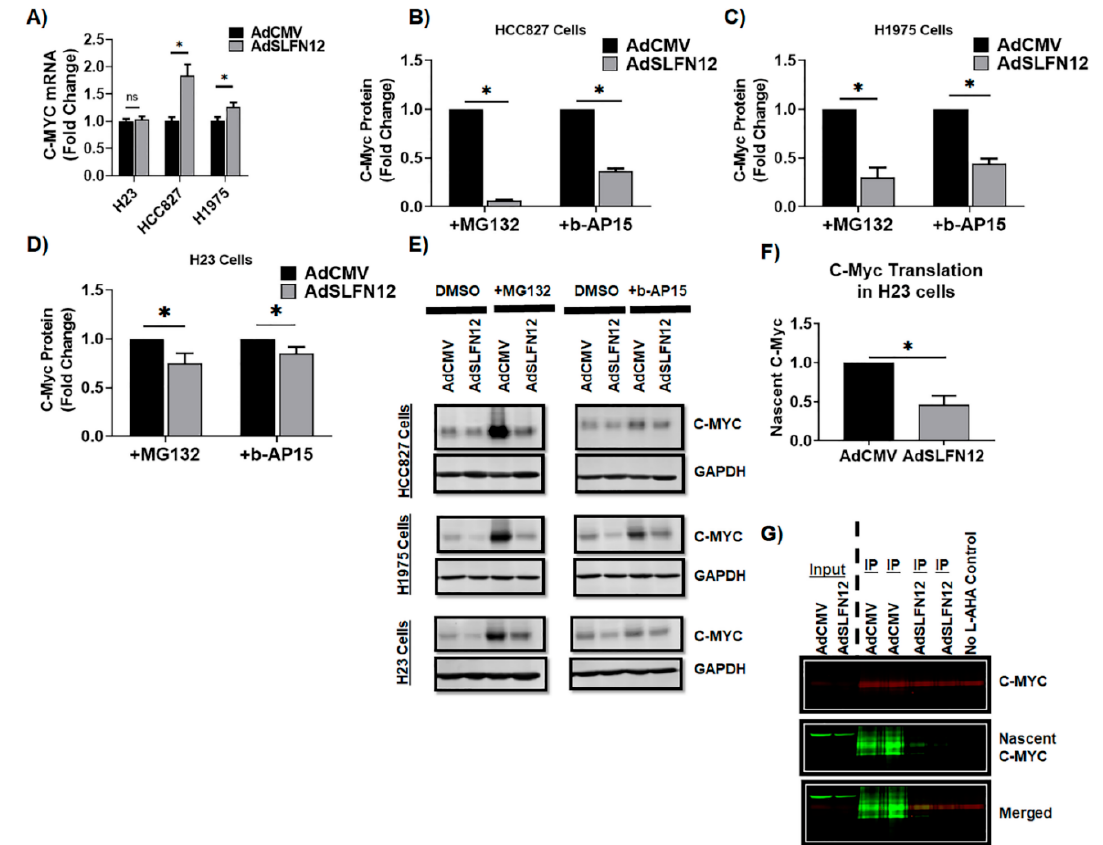
Figure 6. Schlafen 12 reduces c-myc protein translation. ( A ) C-myc mRNA levels analyzed by primer-probe RT-qPCR in HCC827 ( n = 6), H23 ( n = 6), and H-1975 ( n = 6) LUAD cells, 72 hours after AdSLFN12 or AdCMV treatment. HPRT was used as a reference gene and data were normalized to the AdCMV controls (* p < 0.05, ns = non-significant). C-myc protein levels analyzed by Western blot in ( B ) H1975 ( n = 3), ( C ) H23 ( n = 3), and ( D ) HCC827 ( n = 6) cells, with representative Western blot images shown in ( E ), 72 hours after infection with AdSLFN12 or AdCMV control, in the presence of 10 µM of the proteasomal inhibitor MG132 or 1 µM of the deubiquitylase inhibitor b-AP15 (* p < 0.05, GAPDH used as a reference protein). ( F , G ) C-myc protein translation in H23 cells ( n = 3), 68 hours after treatment withAdSLFN12 or AdCMV control, performed by Click-iT reaction of L-AHA metabolic labeling of newly synthesized (nascent) c-myc protein (green), after immunoprecipitating total c-myc protein (red). Nascent c-myc protein (green) was normalized to the total immunoprecipitated c-myc (red) and all data were then normalized to the control AdCMV values (* p < 0.05). All data are represented as mean ± SEM. Detailed information about western blot can be found at Figure